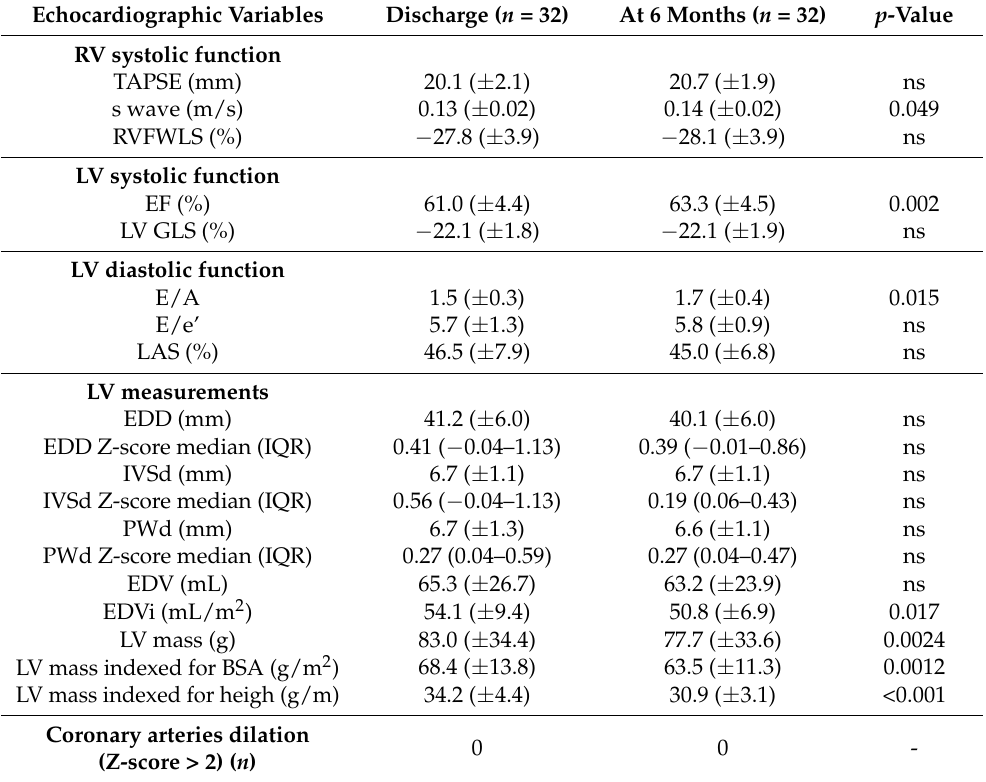
Table 2. Comparison between early (discharge) and late (6 months follow-up) echocardiographic data. Data are expressed in mean ( ± standard deviation). Z-scores are expressed in media (IQR) Legend. BSA (body surface area), EDD (end-diastolic diameter), EDV (end-diastolic volume), EDVi (end-diastolic volume indexed for body surface area), EF (ejection fraction), IVSd (interventricular septum diastolic), LAS (left atrium strain), LV GLS (left ventricle global longitudinal strain), ns (not significant), PWd (posterior wall diastolic), RVFWLS (right ventricle free wall longitudinal strain), TAPSE (tricuspid annular plane systolic excursion). Echocardiographic